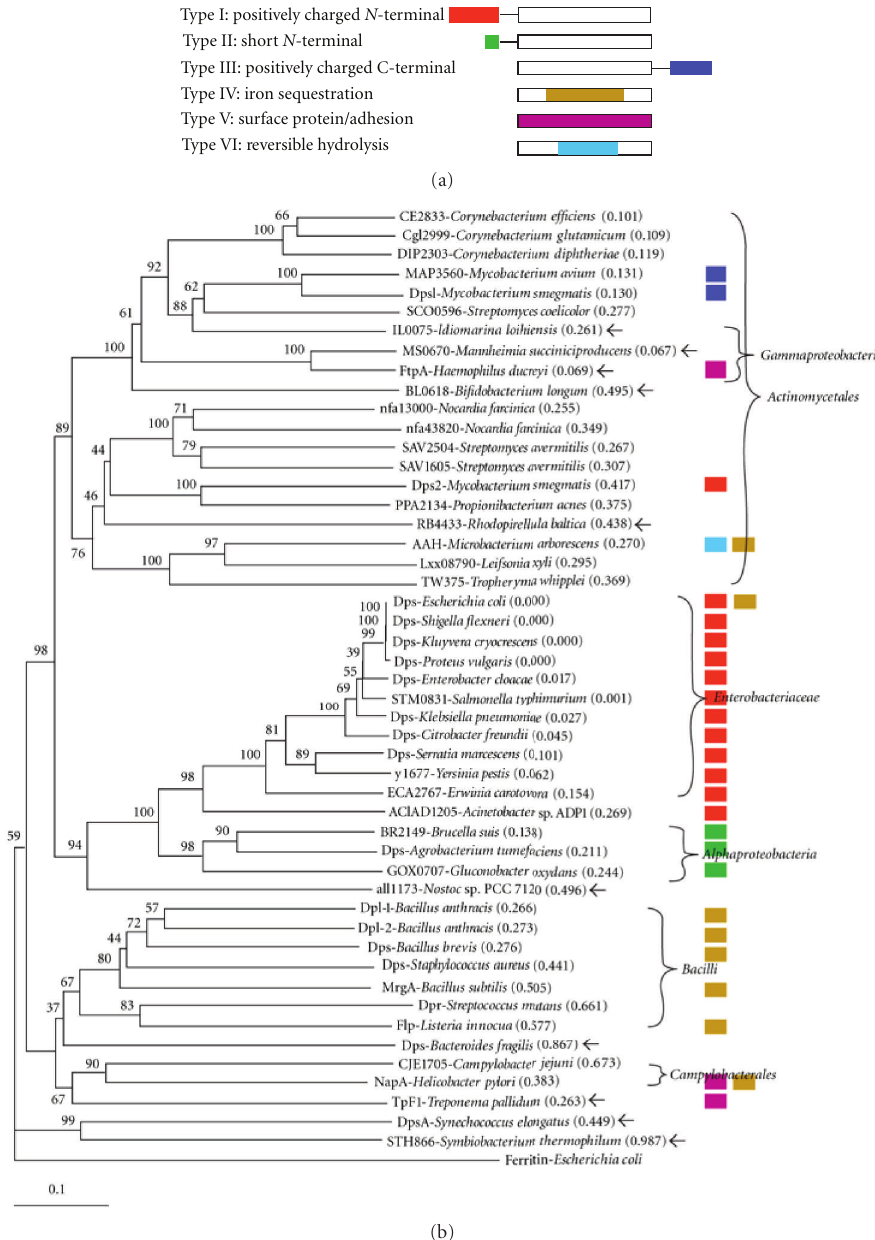
Figure 1: Functional domain, taxonomy, and sequence similarity of Dps-like proteins. (a) Diagram display of the functional domains of Dps-like proteins. Domains are colored as described on the left. The open blank bar depicts the protein including ferroxidase center. (b) Cladogram of some Dps-like proteins with branch lengths in accordance with their relative evolutionary distance. The unit is shown on the bottom. Another set of independently calculated distance values was given in parentheses. The bootstrap values (%) of 1000 repeats were labelled on the knots. Protein names were followed by the host species. Putative proteins were labelled with the gene tag in corresponding genome projects. The ferritin from E. coli was chosen as out-group. The classification of the corresponding hosts was shown on right. Those proteins whose sequence similarities and host phylogeny do not match were marked by arrows. The protein domains were shown as squares with the same color in (a). The protein IDs were listed in the Supplementary Material available